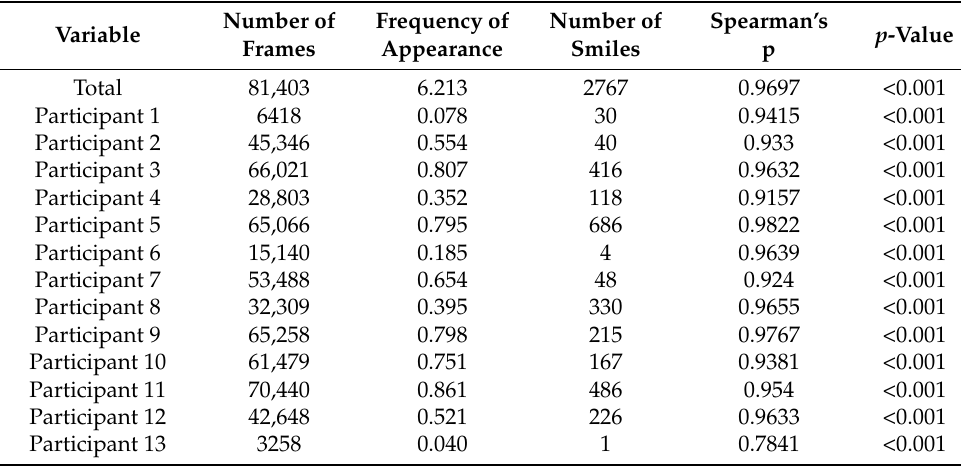
Table 2. Correlation between smile and joy